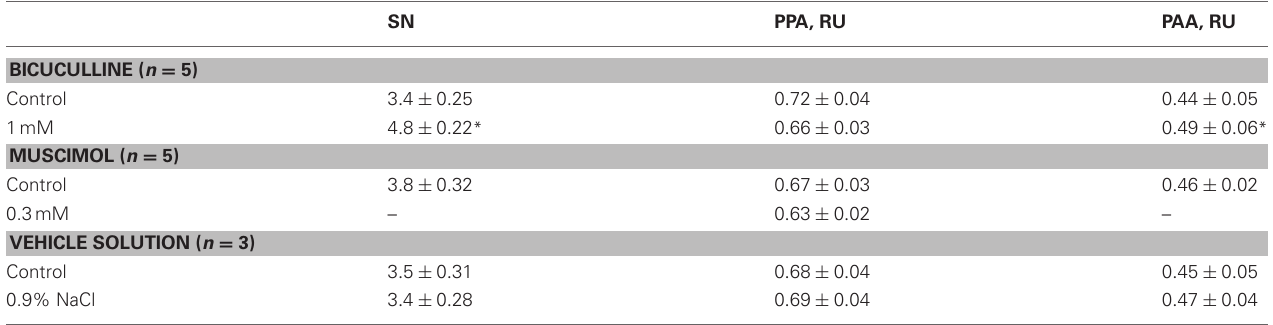
Table 3 | Changes in some sneeze-related variables recorded ∼ 10min following bilateral microinjections of 1mM Bicuculline, 0.3 Muscimol, and vehicle solution into the cVRG.